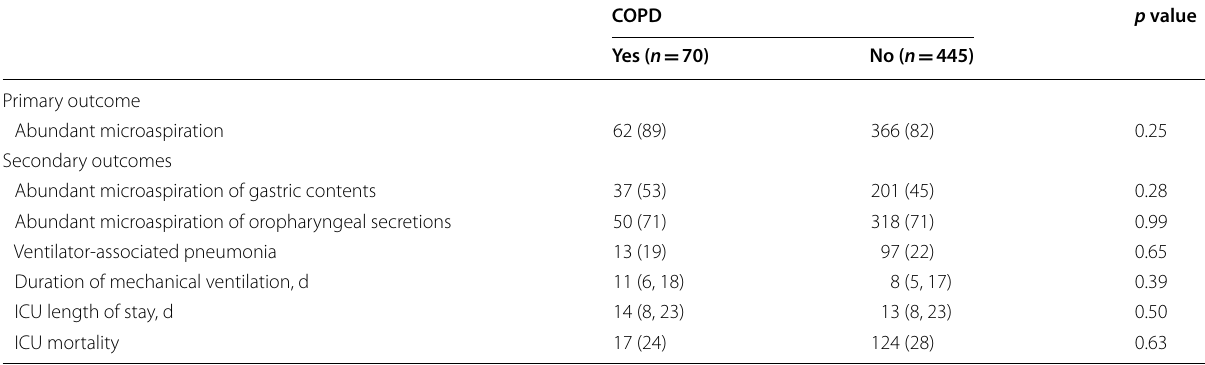
Data are median (IQ), or number